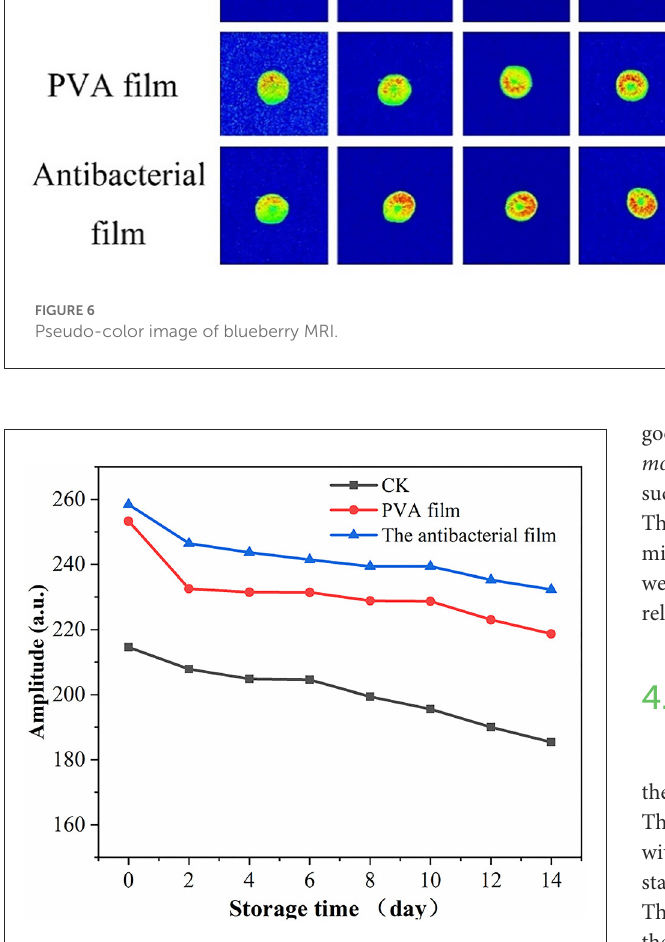
FIGURE7 Overall moisture change of blueberries during